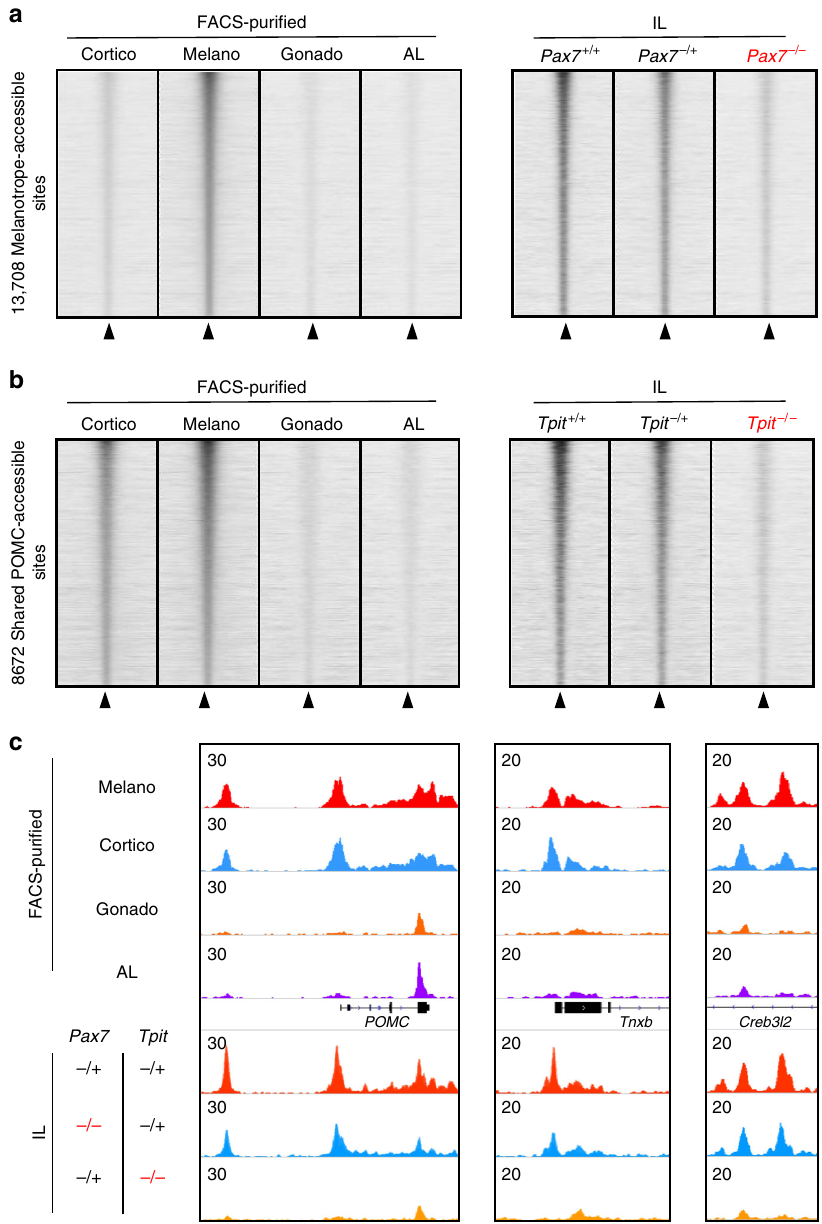
Fig. 4 Pax7 and Tpit are required for opening cognate enhancer landscapes. a Read density heatmaps showing assay for transposase-accessible chromatin using sequencing (ATACseq) signals (reads per kilobase of transcript, per million mapped reads (RPKM)) across the different pituitary lineages in a 4kb window centered at melanotrope-speci fi c ATAC peaks (left panel). Right panel shows corresponding ATACseq heatmaps in the ILs of WT , Pax7 + / − ;Tpit + / − (labeled Pax7 + / − ) and Pax7 − / − ;Tpit + / − (labeled Pax7 − / − ) mice. b Read density heatmaps showing ATACseq signals (RPKM) across the different pituitary lineages in a 4kb window centered at pro-opiomelanocortin (POMC)-speci fi c ATAC peaks (left panel). Right panel shows corresponding ATACseq heatmaps in the intermediate lobe of WT , Pax7 + / − ;Tpit + / − (labeled Pax7 + / − ) and Pax7 − / − ;Tpit + / − (labeled Pax7 − / − ) mice. c Genome browser view (Integrative Genomics Viewer (IGV)) of ATACseq pro fi les at POMC-speci fi c ATACseq peaks in the different pituitary lineages and in ILs of Pax7 + / − ;Tpit + / − , Pax7 − / − ;Tpit + / − , and Pax7 + / − ;Tpit − / −